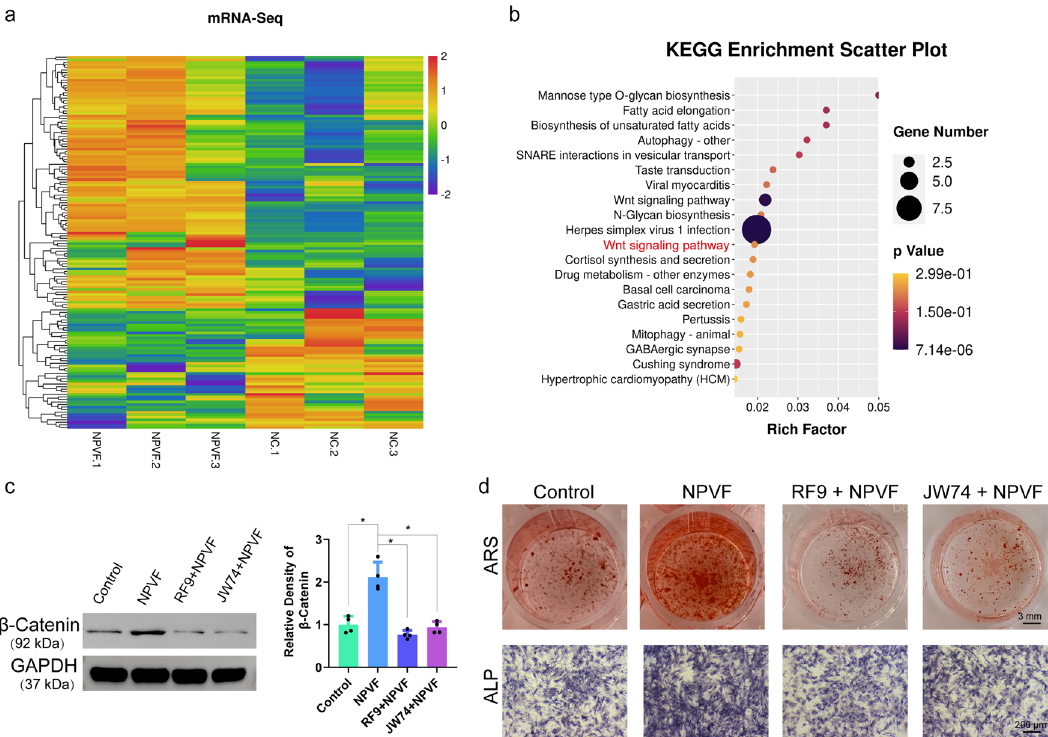
Fig. 4 The WNT/ β -catenin pathway mediates the NPVF-induced osteogenic differentiation of BMSCs. a The results of miRNA sequencing of BMSCs treated with NPVF. The color represents the relative expression value of miRNA genes. b KEGG enrichment analysis of BMSCs after treatment with NPVF. c The protein expression of β -catenin in BMSCs. Results are presented as means ± S.E.M. of four independent experiments, and the P values from left to right are 0.0013, 0.0754, and 0.092. * P < 0.05, one-way ANOVA. d ARS and ALP staining of BMSCs undergoing osteogenic